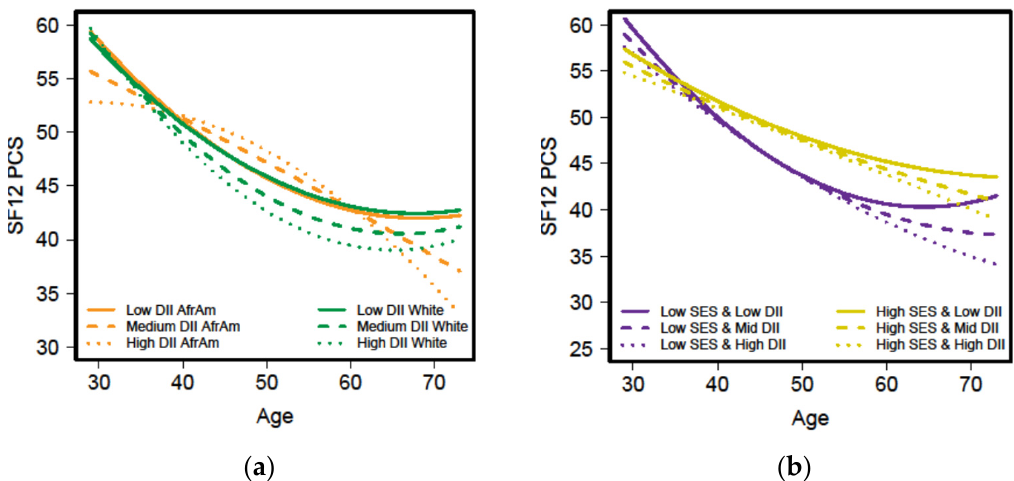
Figure 4. Short Form-12 Physical Component Scores ((SF-12 PCS) by age for HANDLS men across three levels of the dietary inflammatory index (DII) and either race (( a ) African American (AfrAm) and White) or socioeconomic status (( b ) SES). HANDLS-Healthy Aging in Neighborhoods of Diversity across the Life Span.